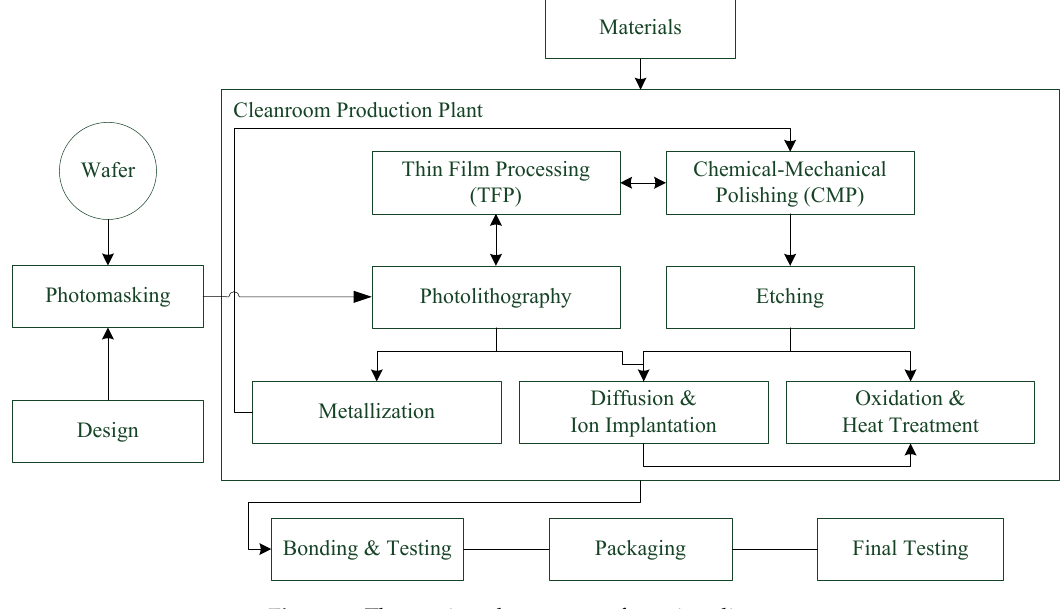
Figure 1. The semiconductor manufacturing diagram.